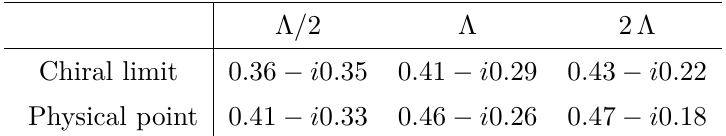
√ Table 1 . Lightest pole positions in the variable s σ and in units of GeV of the σ -resonance in QCD and using the unitarized S -wave ππ PWA at leading order (Born term) in ChPT. We show results for the chiral limit and the physical point, and for the nominal cutoff of the EFT, Λ = 4 πf π , and variations of factor 2